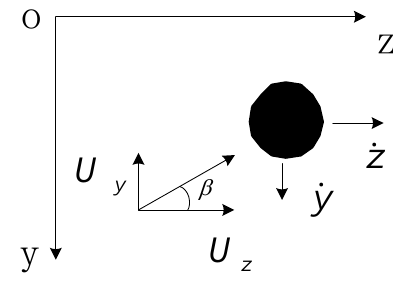
Figure 14. Cross-section of cable under lateral wind load.